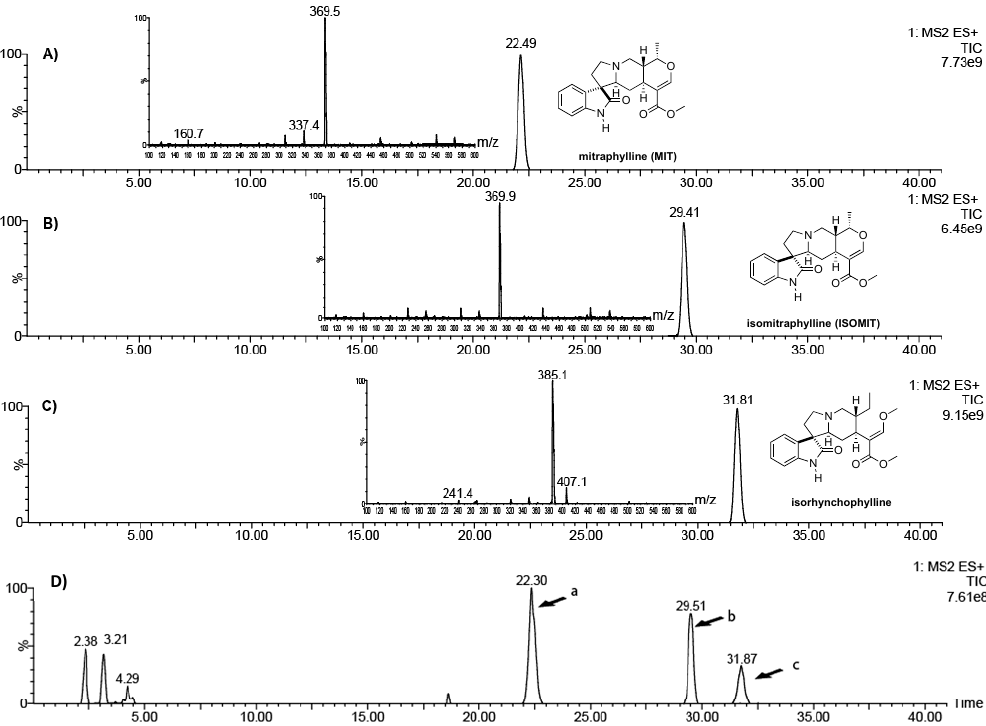
Figure 1. Ultra-performance liquid chromatography-mass spectrometry (UPLC-MS) chromatograms of ( A ) mitraphylline, ( B ) isomitraphylline, ( C ) isorhynchophylline, and (ALE) aqueous leaf extract from Uncaria tomentosa ( D ). The peaks are labeled ( a ) mitraphylline, ( b ) isomitraphylline, and ( c ) isorhynchophylline. Table 1. Antioxidant activity of Uncaria tomentosa leaf extract tested by in vitro assays.